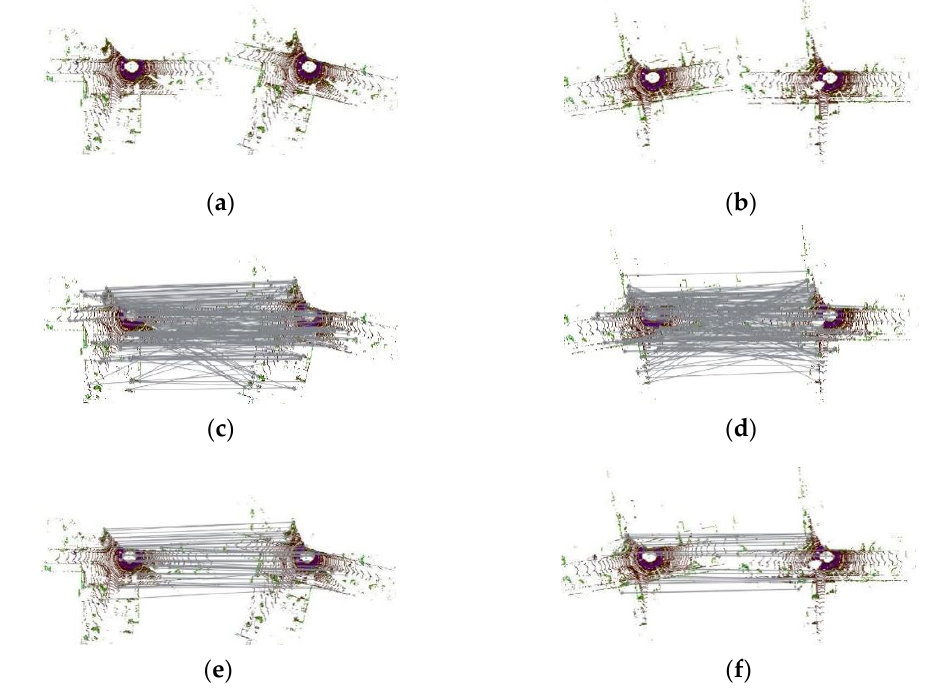
Figure 5. The visualization of DTORB matching progress, they should be listed as ( a , b ) two pairs of LCD in KITTI-05; ( c , d ) the visualization of matching performed by traditional ORB; ( e , f ) the visualization of the proposed DTORB.